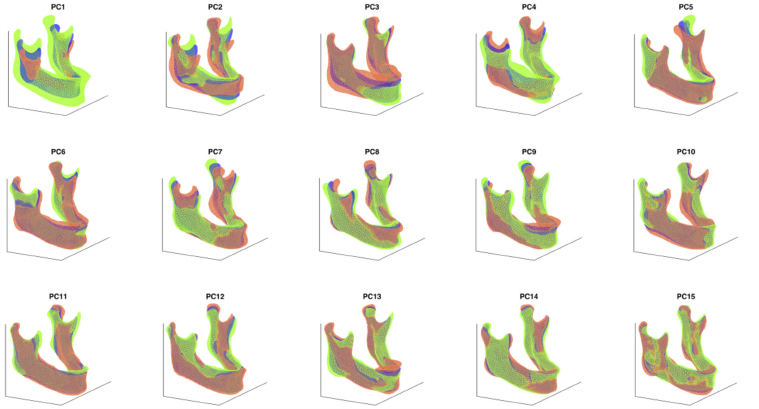
Figure 3. The first 15 mandible principal components (PCs). The average mandible shape is rep- resented in blue, while the deformations along the i th PC applying a weight equal to reported in